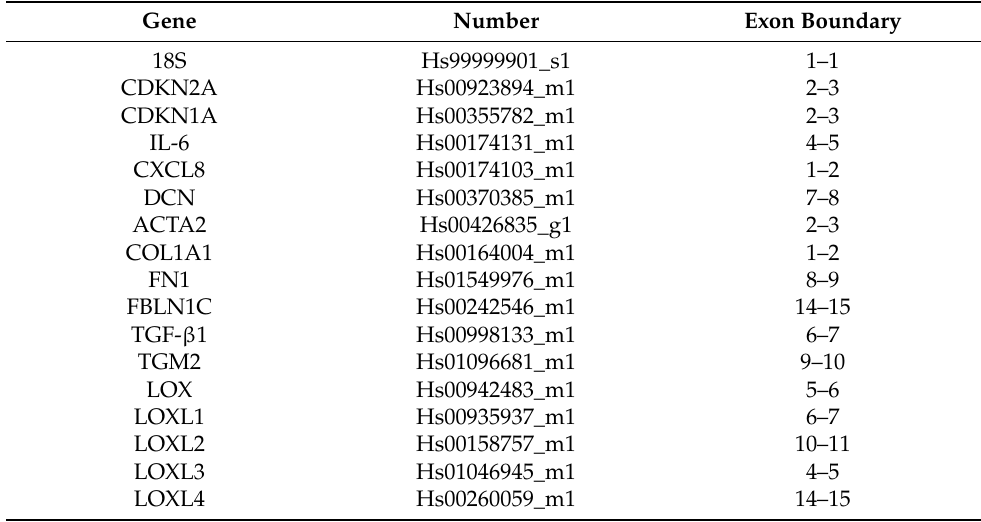
Table 3. Primers and probed with designated exon